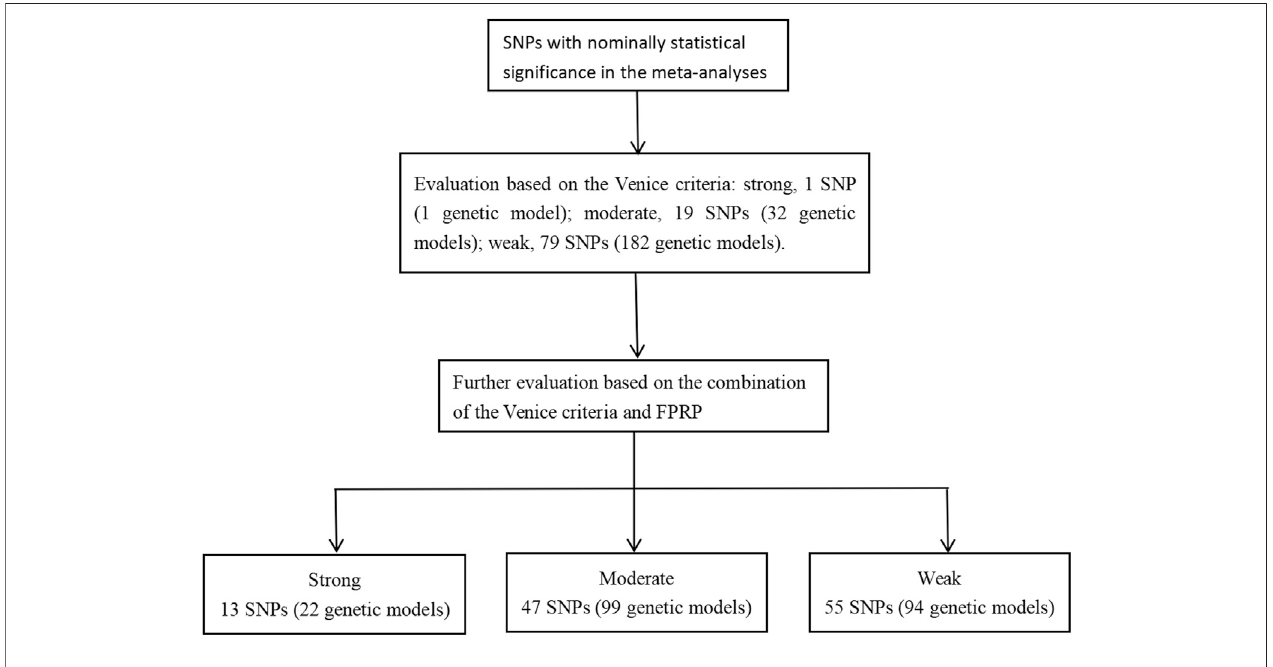
FIGURE 2 | The evaluation process of cumulative